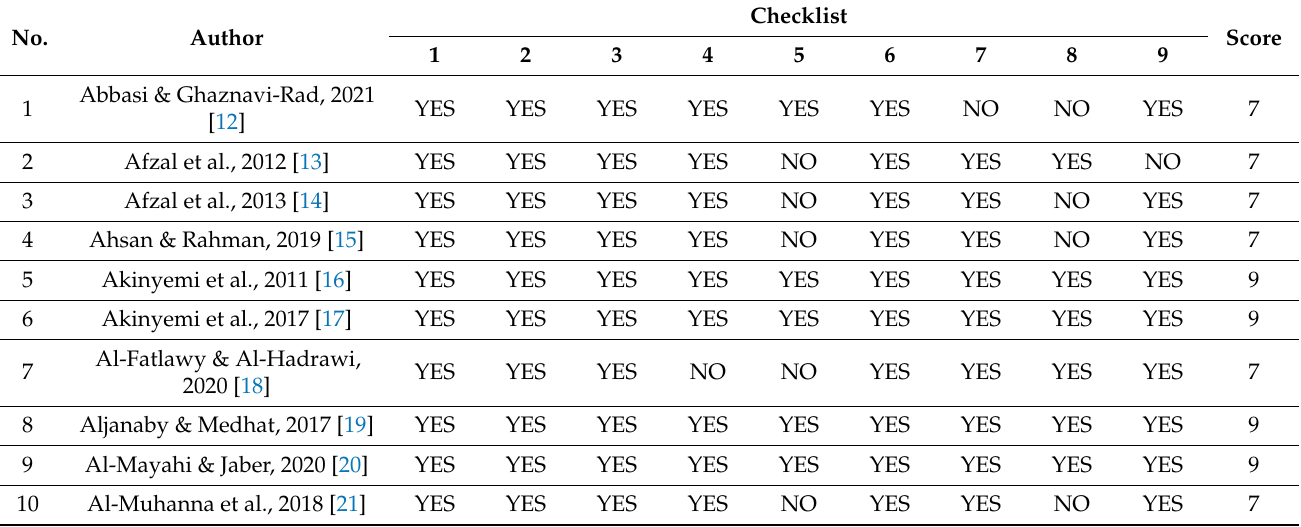
Table A1. Quality of included studies by JBI critical appraisal checklist for studies reporting preva- lence